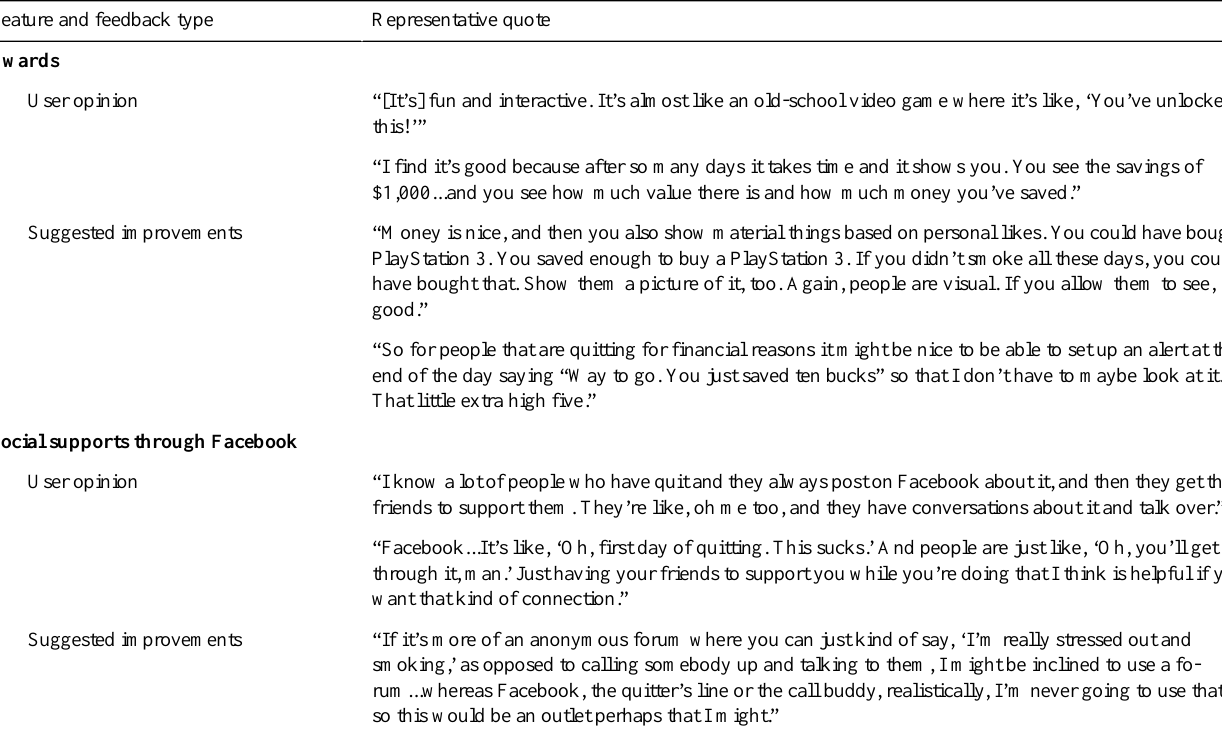
Representative quoteFeature and feedback